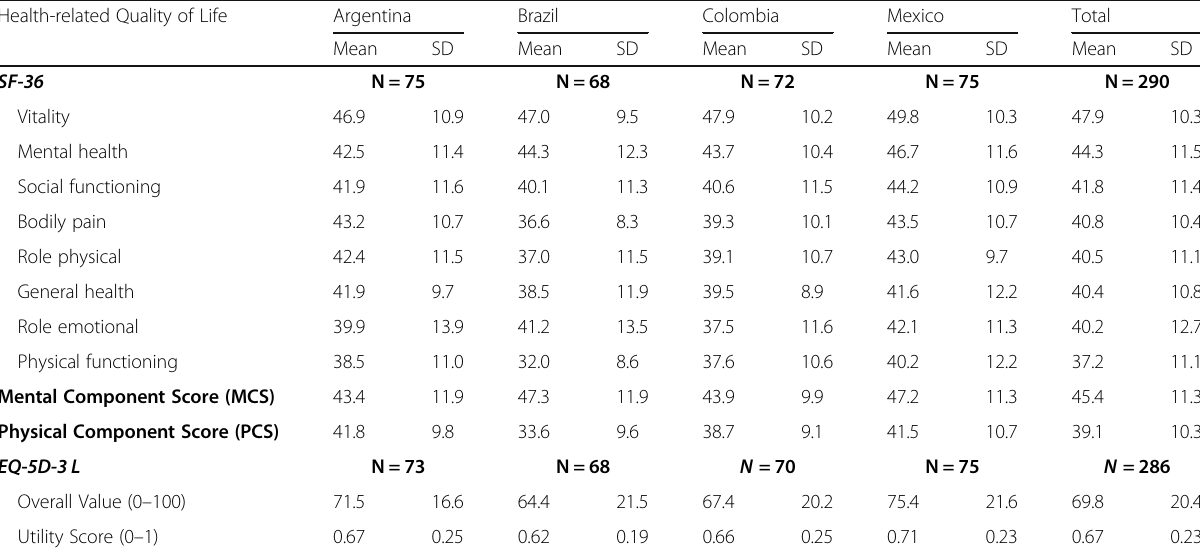
Table 4 Health-related quality of life assessed through SF-36 and EQ-5D-3 L questionnaires among RA patients at baseline Health-related Quality of Life